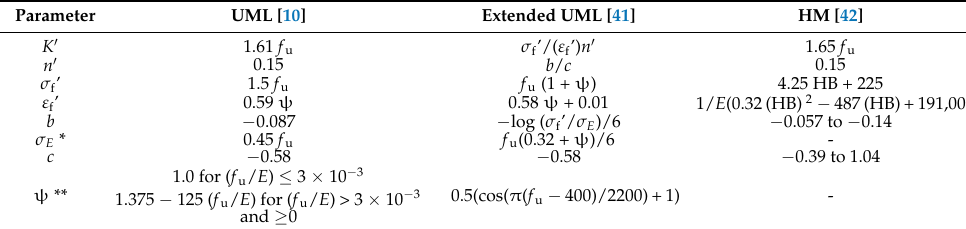
Table 1. Cyclic material parameters for strain–life curve. Parameter UML